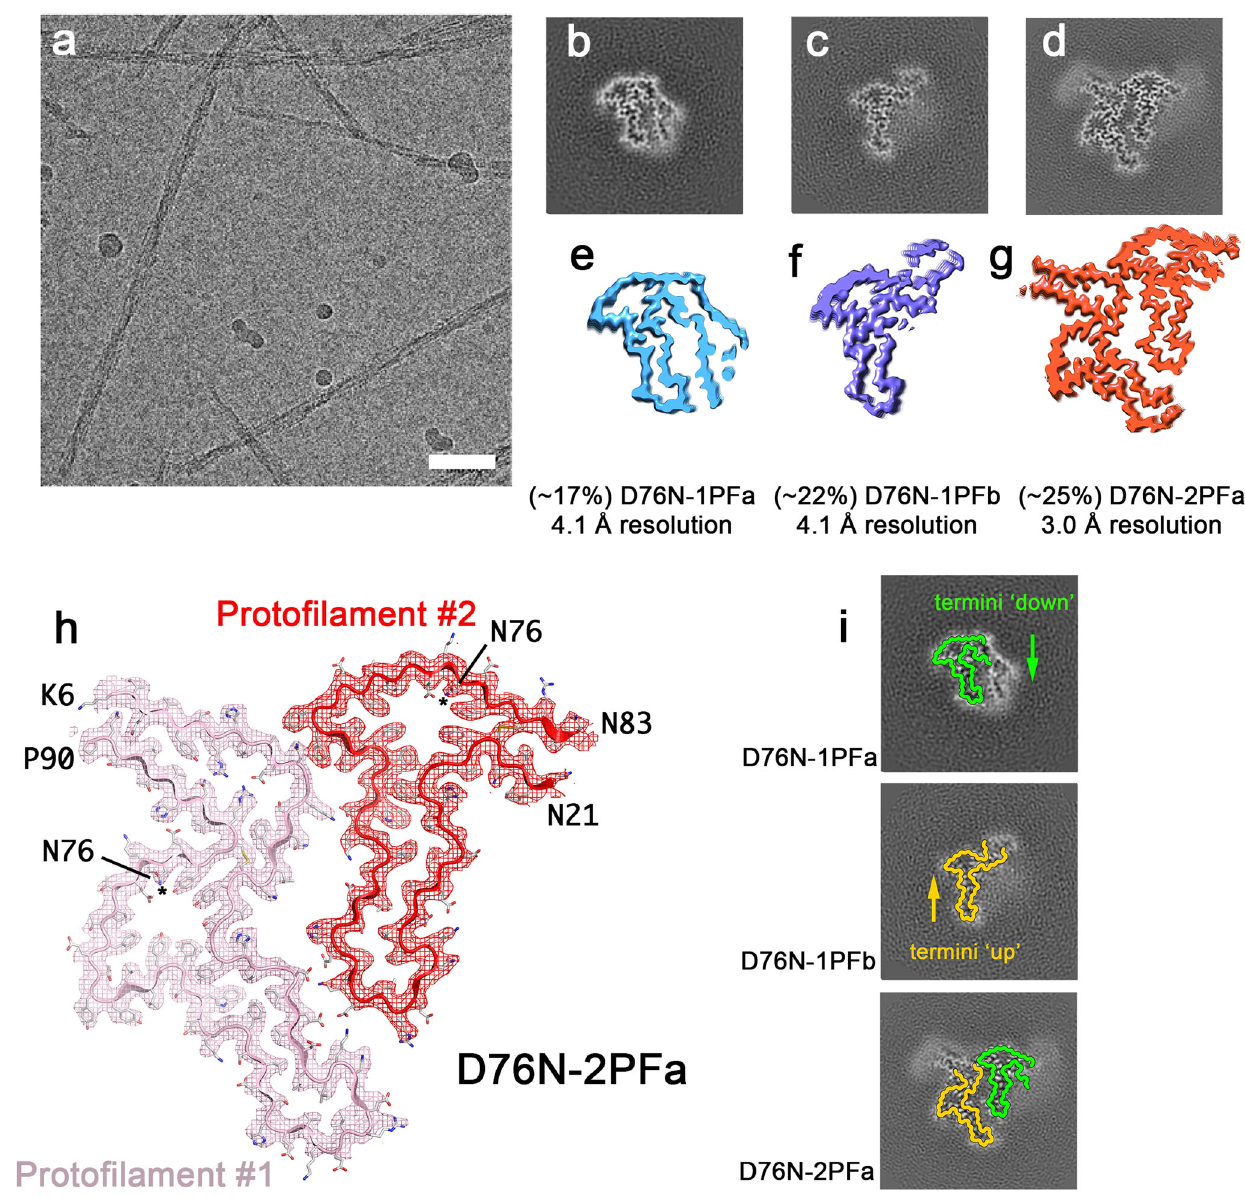
Fig. 4 | Polymorphism in β 2 m-D76N fi brils. a Representative cryoEM micrograph of β 2 m-D76N fi brils (scale bar corresponds to 50nm). Two independent experi- ments were performed, with similar results. b – d Cross sections through the 3D reconstructions of the three polymorphs found in the β 2 m-D76N data: b D76N- 1PFa, c D76N-1PFb and d D76N-2PFa. As in Fig. 2, cross-section represents the sum of the reconstructed densities for six XY-slices, equivalent to one rung of the amyloid fi bril. e – g Surface representation of the same structures with relative